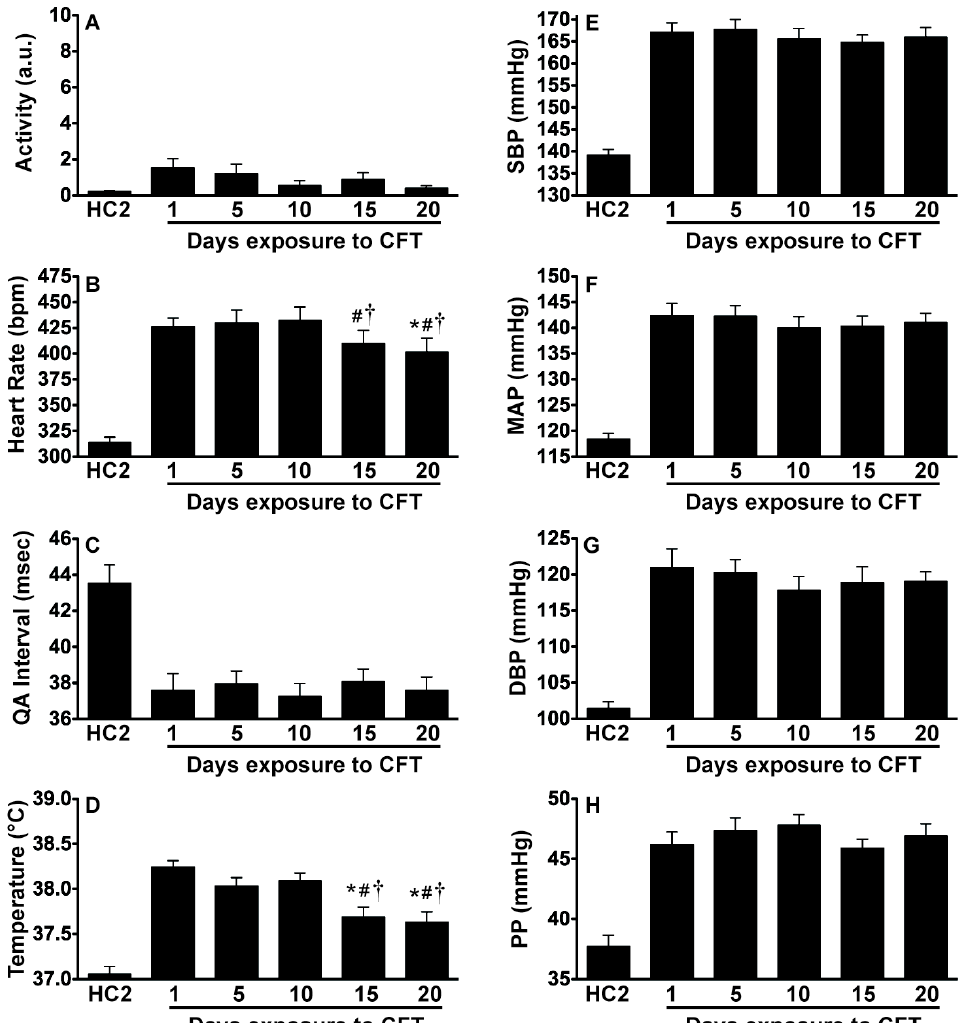
Figure 6. Reduction in fear-evoked increases in heart rate and body temperature with repeated exposure to CFT. In vivo telemetry measurements demonstrating